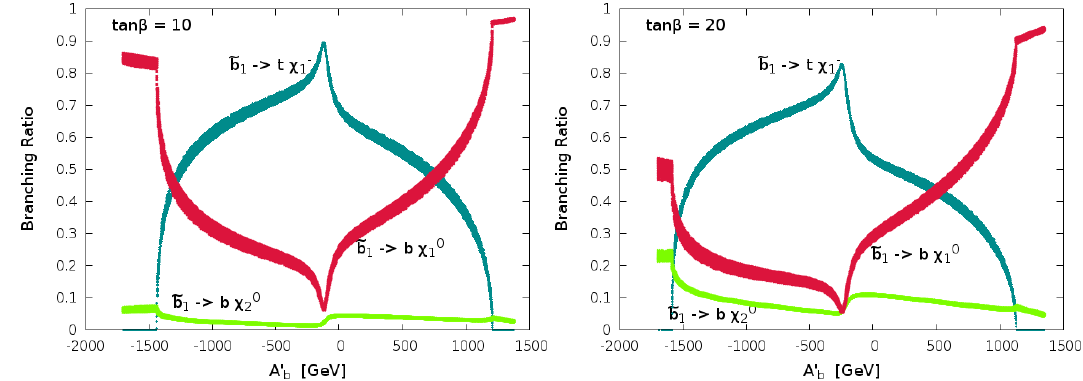
Figure 5 . Variations of various decay branching fractions of ~ b 1 as a function of A 0 is higgsino-like for tan (cid:12) = 10 (left) and tan (cid:12) = 40 (right). Other (cid:12)xed/varying input parameters are as in (cid:12)gure 3. A broken ordinate is chosen to present the branching ratio in the plot on the left.